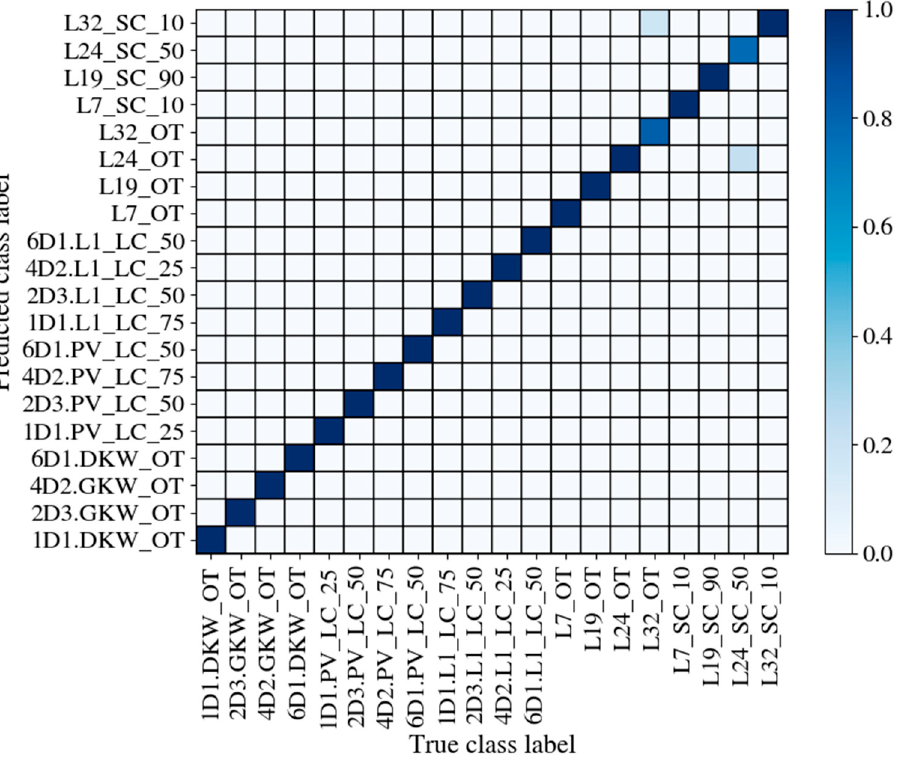
Figure 20. Normalized confusion matrix for training predictions.